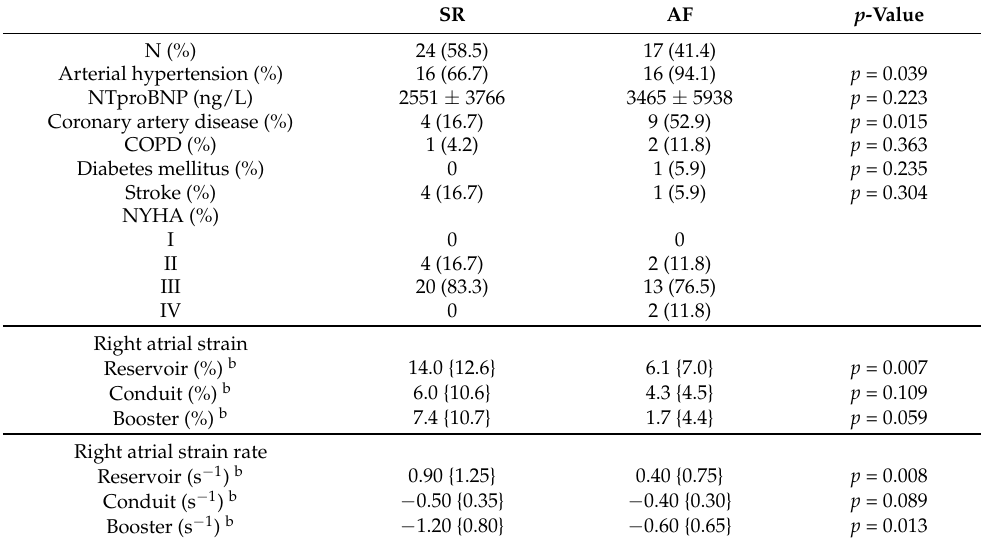
Table 3. CA patients with and without atrial fibrillation.